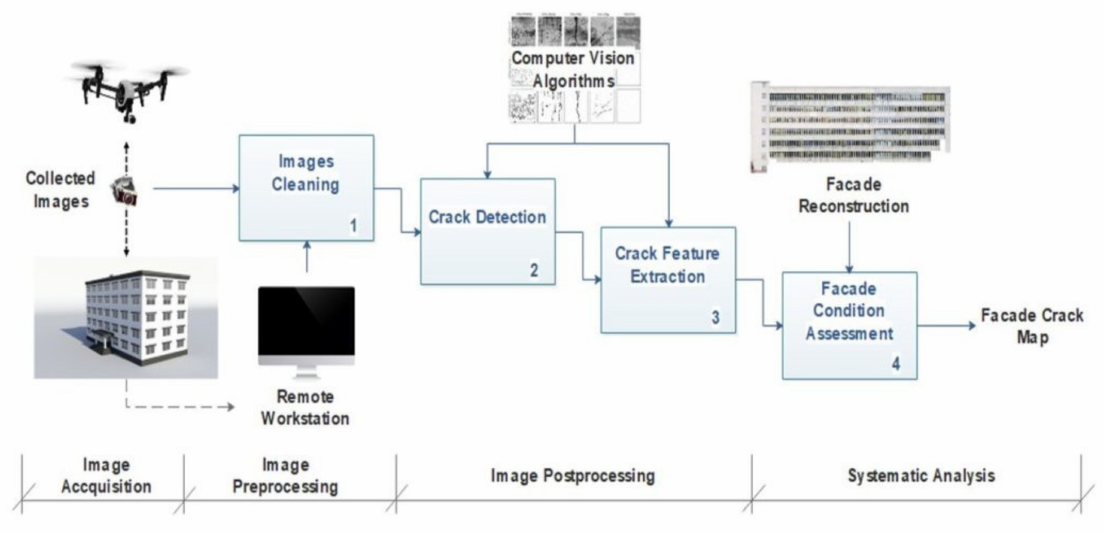
Figure 6. Workflow of a 5G-powered façade inspection system using AI and drones [6].